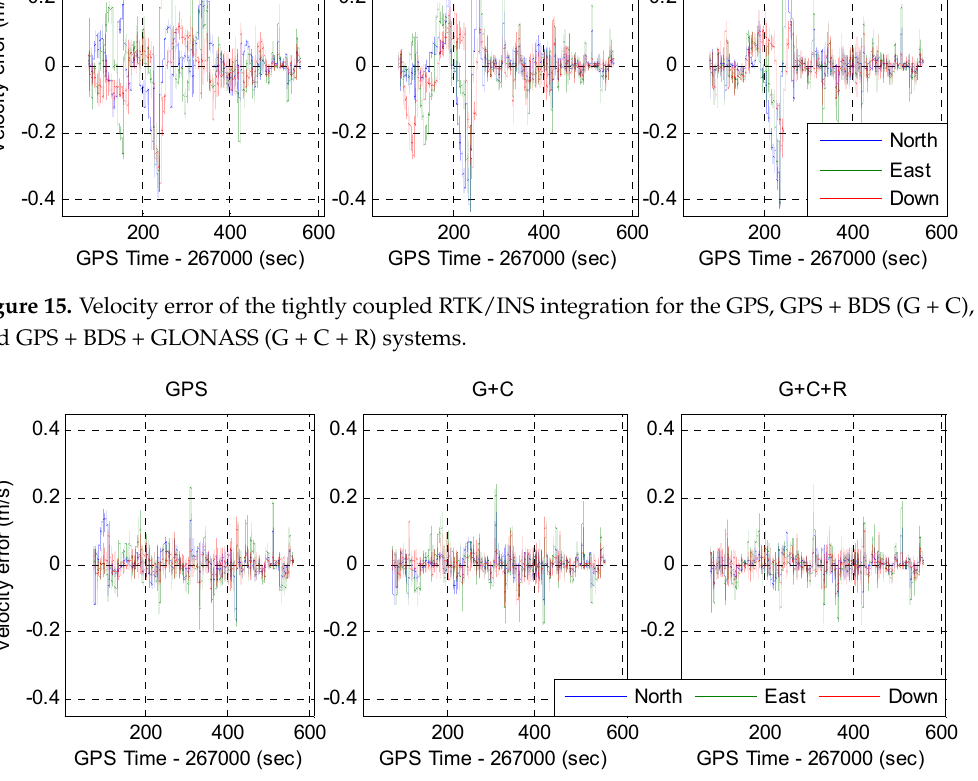
Figure 16. Velocity error of the tightly coupled RTK/INS/Vision integration for the GPS, GPS + BDS (G + C), and GPS + BDS + GLONASS (G + C + R) systems.